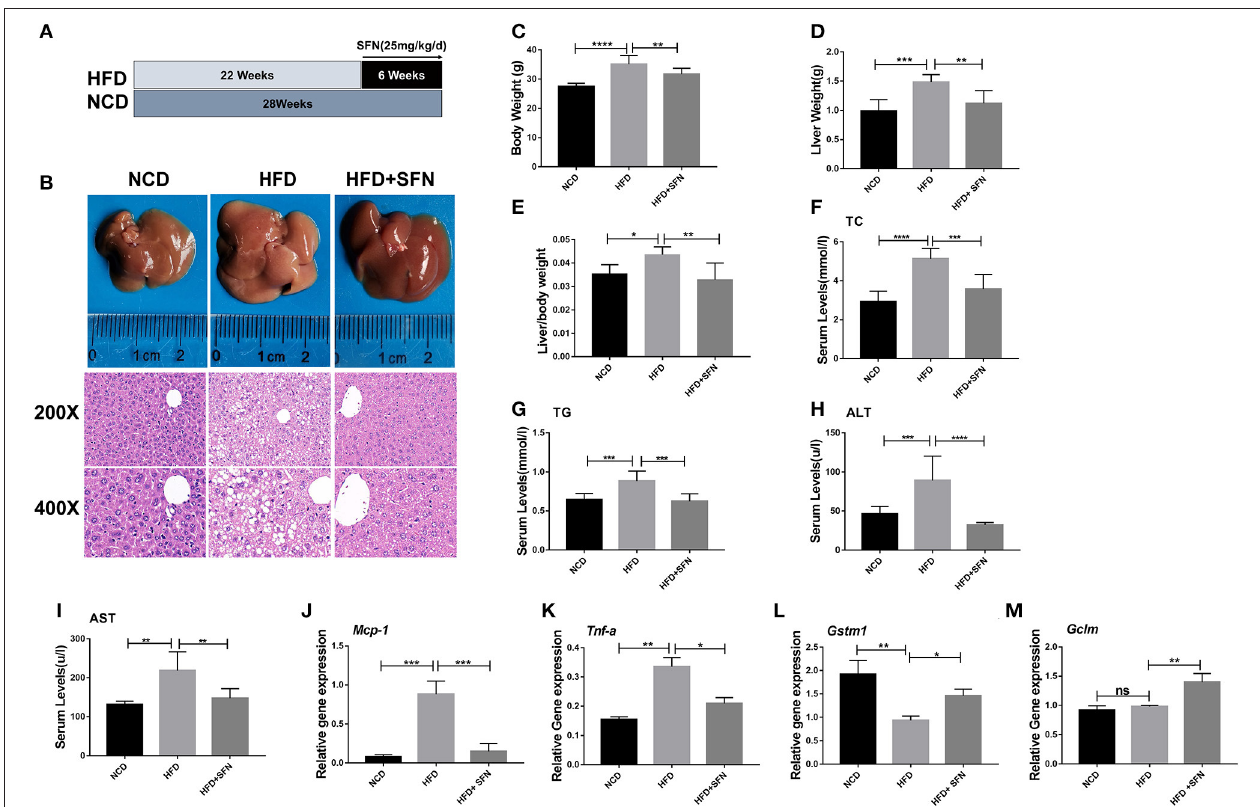
FIGURE 1 | Preventive effects of SFN on the development of HFD-induced NAFLD in mice. (A) Model development and treatment. (B) Representative liver images and H&E staining of liver sections from different groups ( × 400). (C–E) The mice body weight, liver weight and index (liver/body weight). (F–I) Serum levels of TC, TG, ALT and AST. (J,K) The expression of Mcp-1 and Tnf-a in the liver. (L,M) SFN attenuates the expression of anti-oxidative stress mRNA. Data are presented as mean ± SD. ns, not significant, * P < 0.05, ** P < 0.01, *** P < 0.001, **** P < 0.0001 vs. HFD